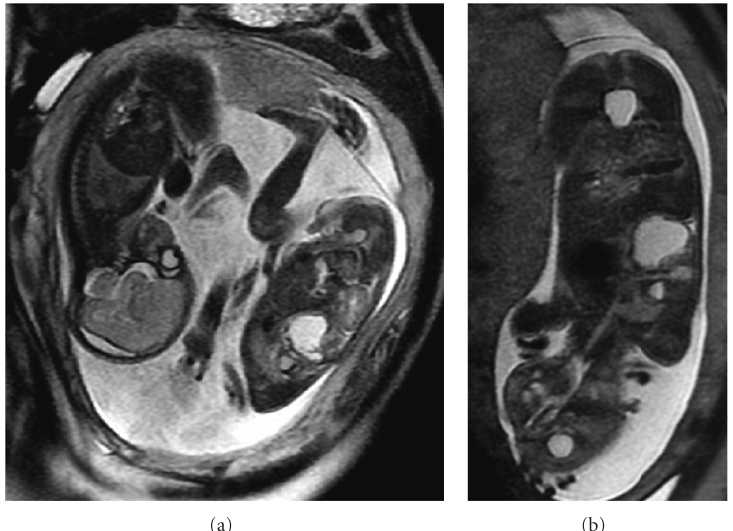
Figure 1: The MR revealed a lesion with several cysts (hyperintensive at T2) occupying a space in the right inferior lobe. A more caudal cyst, and a second cranial cyst with a liquid level were noted.